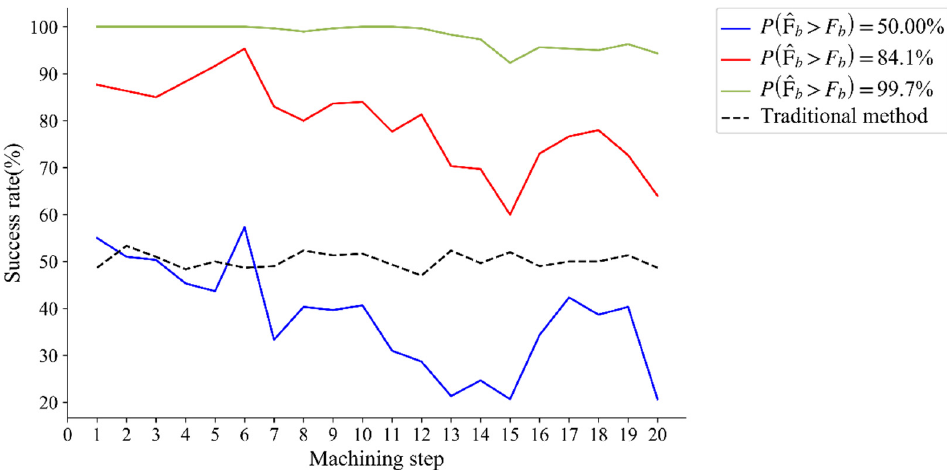
Figure 6. Success rate of clamping force monitoring in each machining step.